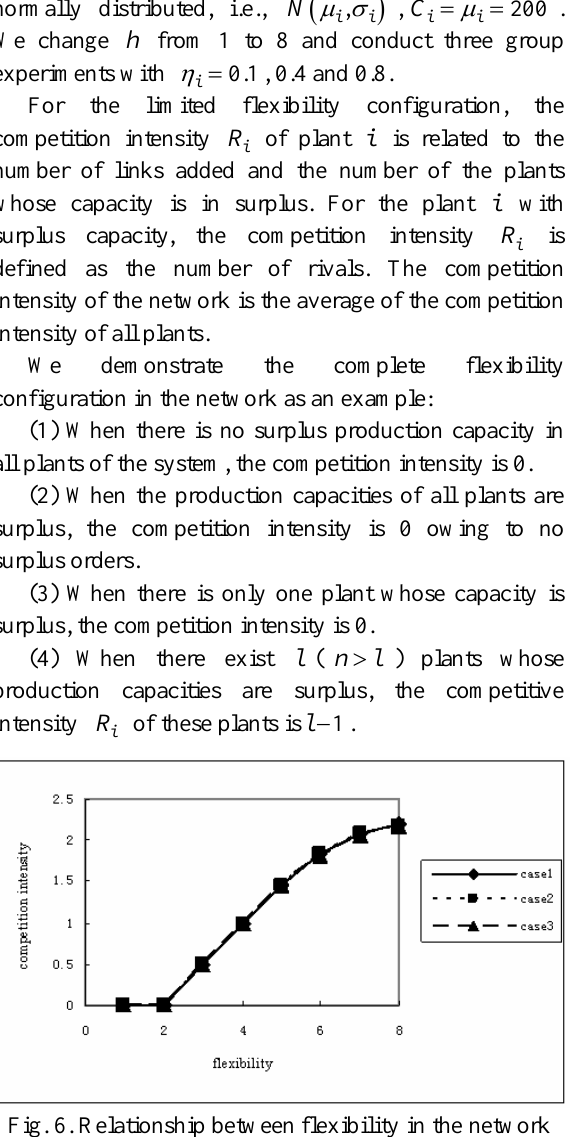
Table 1 ． Relationship between flexibility in the network and the expected profits of the plants Flexibility Plants